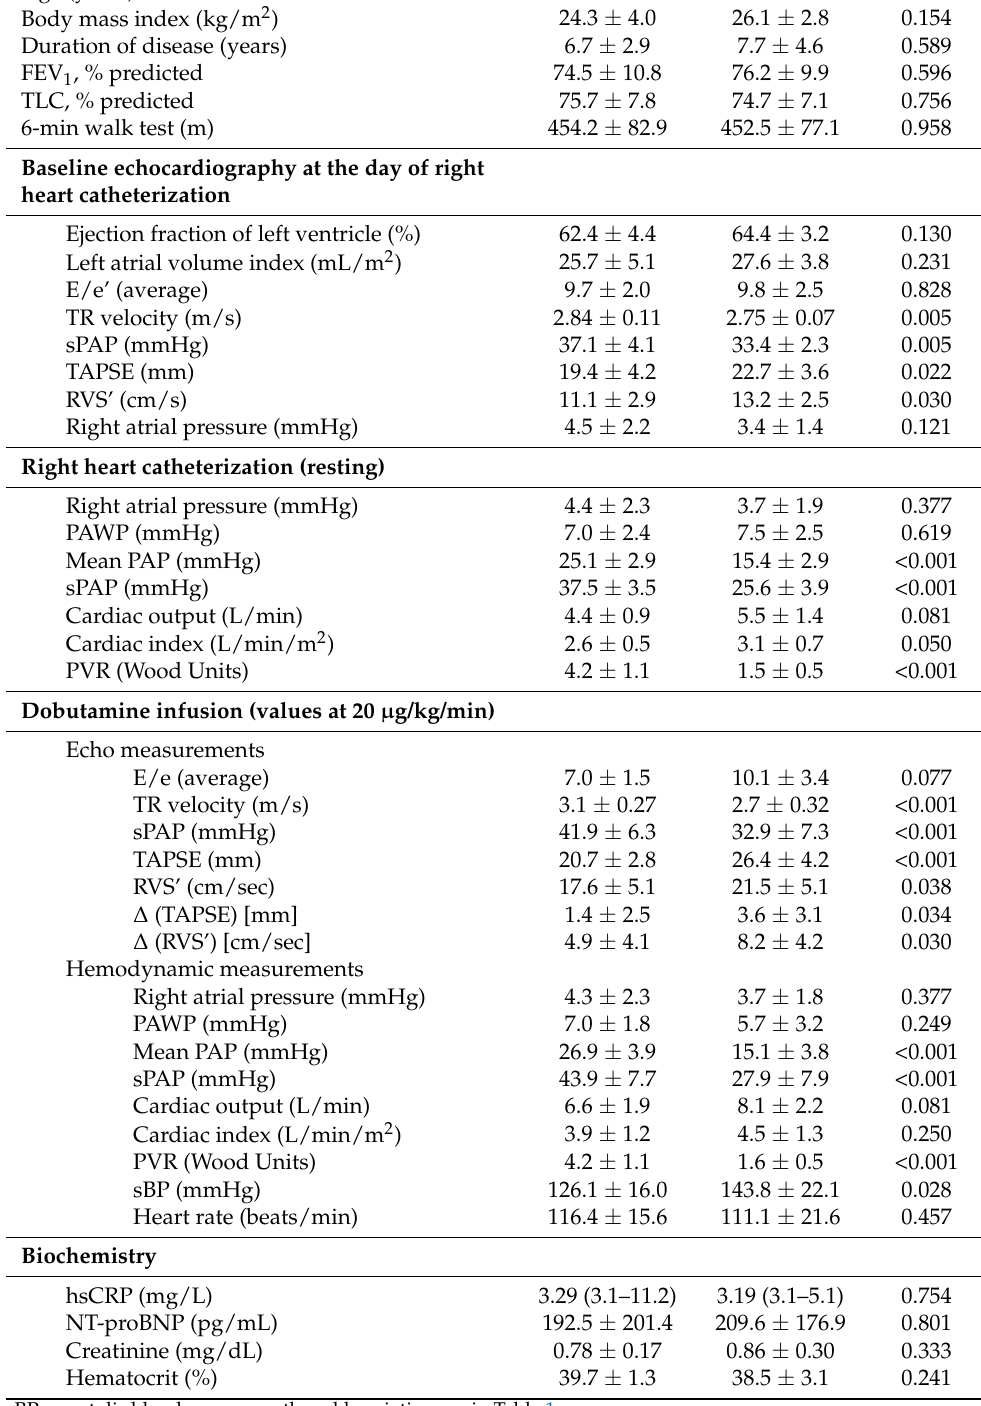
sBP = systolic blood pressure, other abbreviations as in Table